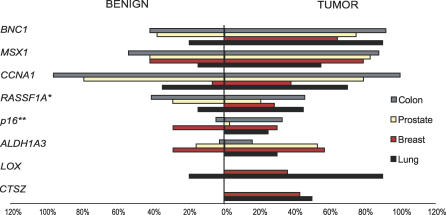
Histogram for Methylation Frequency of Indicated Genes in Prostate, Breast, Lung, and Colon Cancer and Companion Normal TissueMSP data for indicated genes in breast (n = 14; red bars), lung (n = 20; black bars), prostate (n = 24; pale yellow bars), and colon (n = 24; grey bars) tumors and benign tissue (see Methods). Only samples with matching benign and tumor tissue are represented in the histogram. Gels were run and scored as above. SOX15 was omitted from this figure for clarity. Data for RASSF1A were obtained from [17,24,45,46]; data for p16 were obtained from [17,43,44,46].